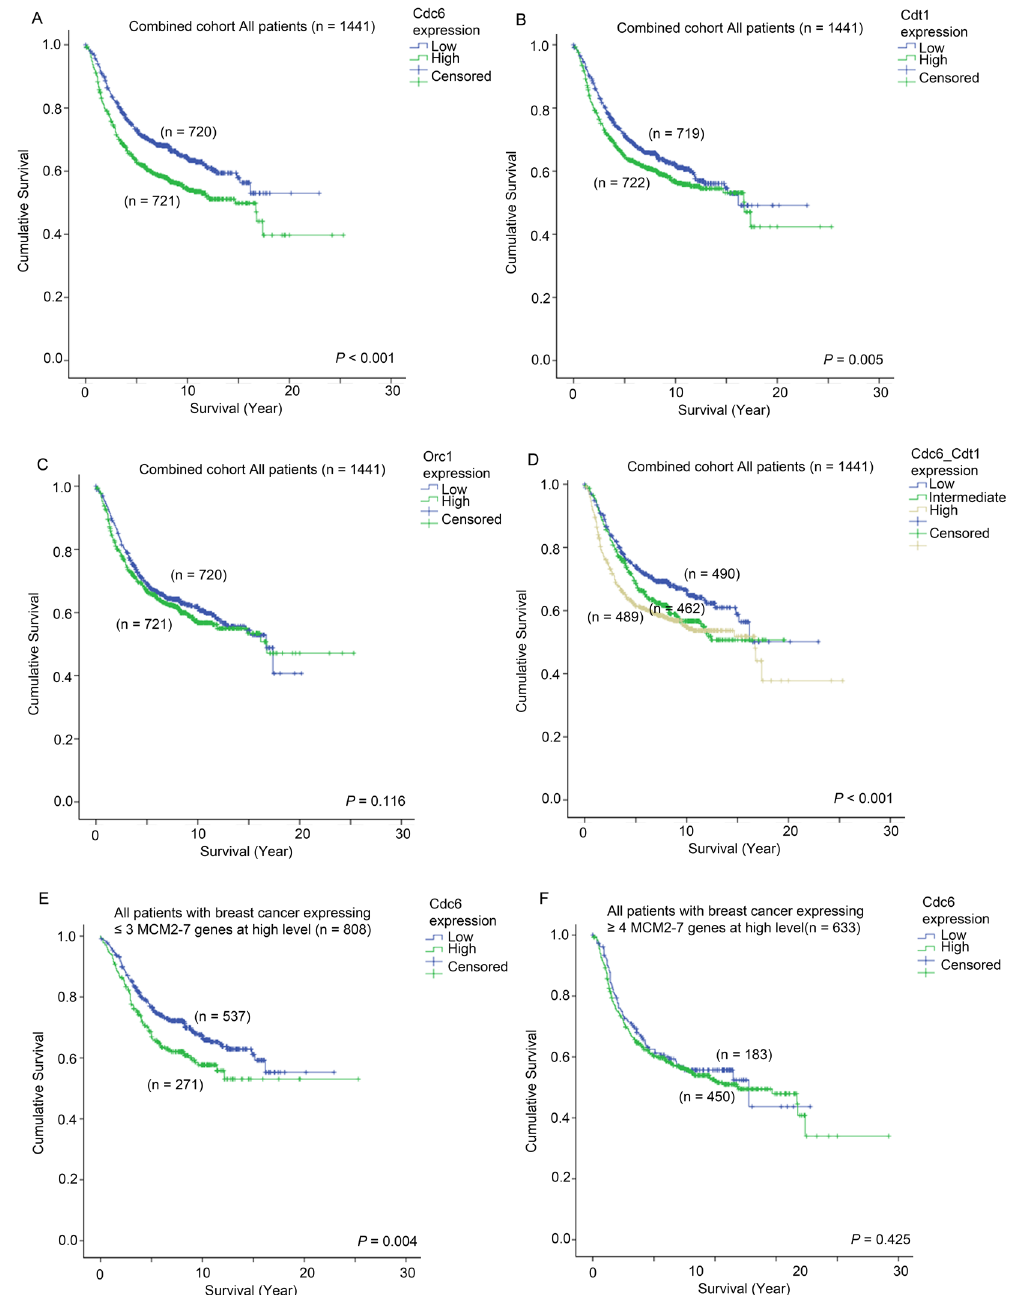
Figure 3. Survival analysis of patients who express different levels of Cdc6, Cdt1 and Orc1. Kaplan-Meier curves showing survival time of patients who express different levels of ( A ) Cdc6, ( B ), Cdt1 and ( C ) Orc1 in the combined breast cancer patient cohort. ( D ) Kaplan Meier curves showing survival time of patients who express different levels of Cdc6 and Cdt1 analyzed in combination in the whole breast cancer patient cohort. Kaplan Meier curves showing survival time of patients expressing different levels of Cdc6 in breast cancer cohort stratified based on the number of MCM genes they overexpress (E ≤ 3 MCMs overexpressed) and (F ≥ 4 MCMs